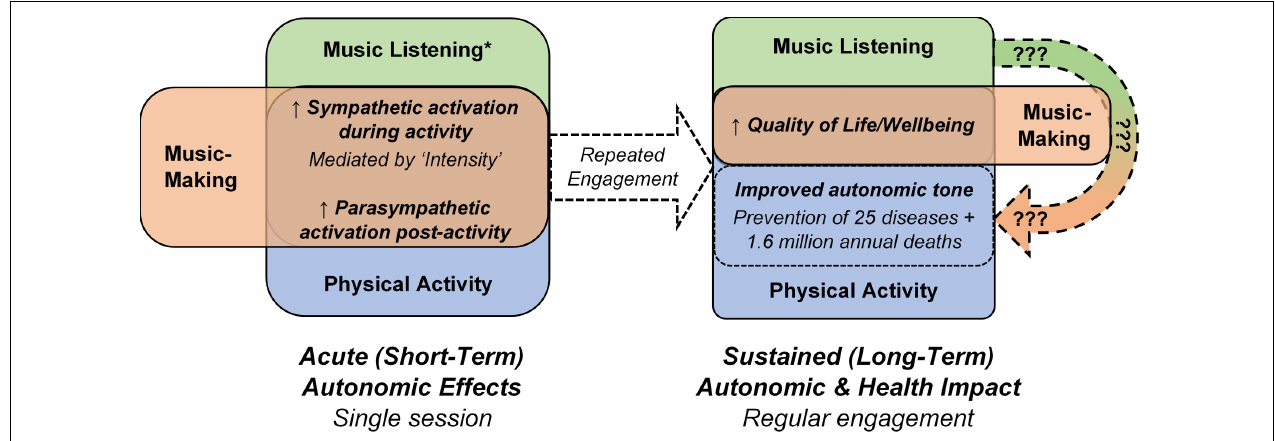
FIGURE 1 | Comparison of the acute autonomic and sustained autonomic and health effects of music listening, music-making and physical activity. The unclear impact of music listening and music-making on autonomic tone and related health outcomes (Fancourt and Finn, 2020; McCrary et al., 2021) is noted by the curved arrow containing question marks. * does not apply to all types of music listening; some types of music listening elicit parasympathetic responses during the listening